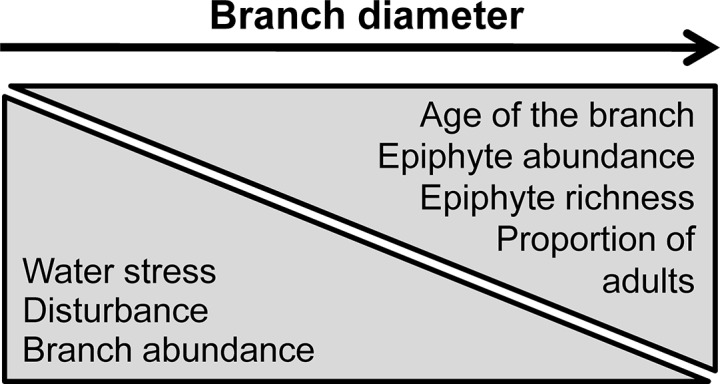
Summarizing scheme of the expected trends with increasing branch diameter.We expect a decrease in water stress, mechanical disturbance and branch abundance with an increasing branch diameter. These drivers plus the increase in branch age should lead to higher epiphyte colonization and survival and an increase in epiphyte abundance, richness and proportion of adults per branch.